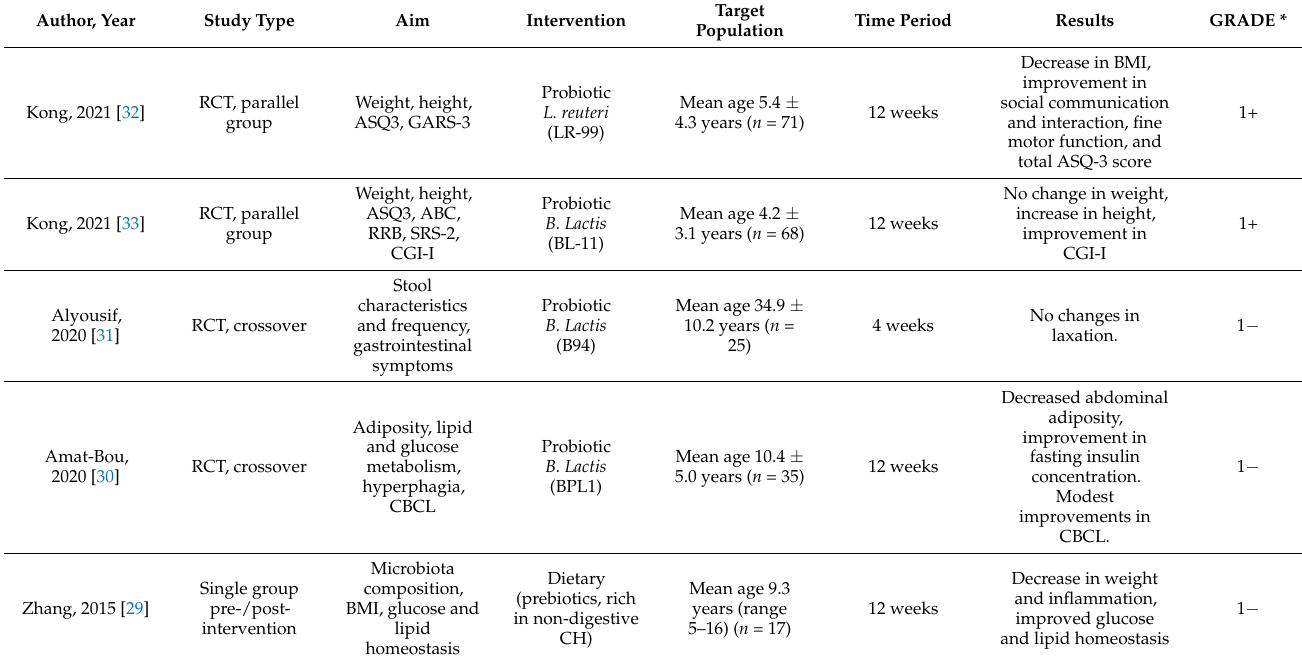
Table 2. Intervention studies targeting the gut microbiome in subjects with